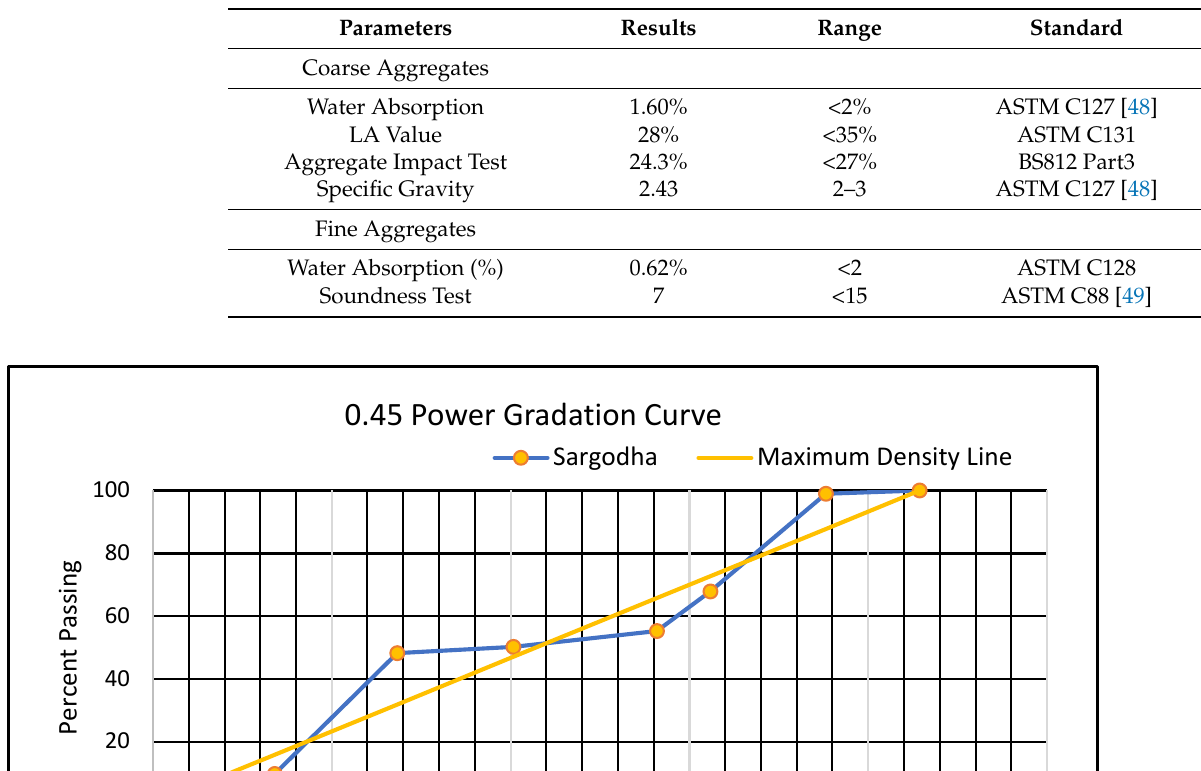
Table 2. Physical characteristics of utilized aggregates for asphalt mix concrete. Table 2 . Physical characteristics of utilized aggregates for asphalt mix concrete.